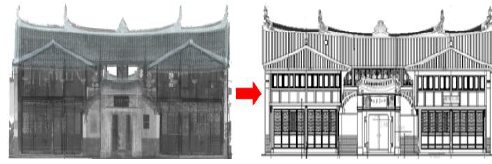
Figure 6 . Elevation drawing collection